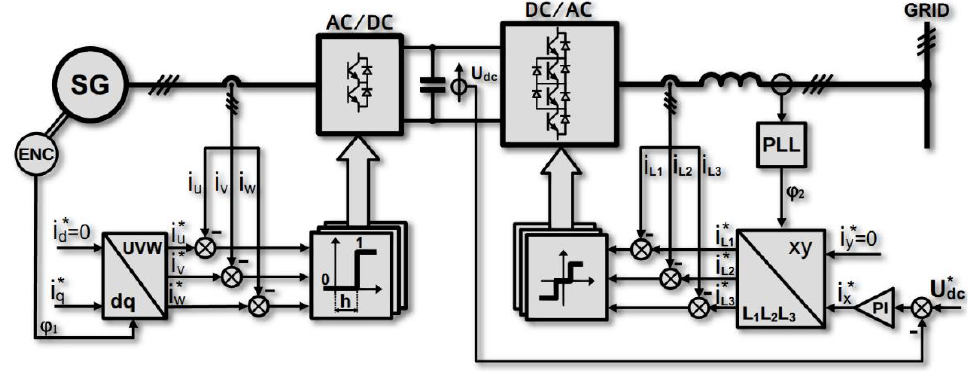
Figure 2. Converter control scheme — topology T1.